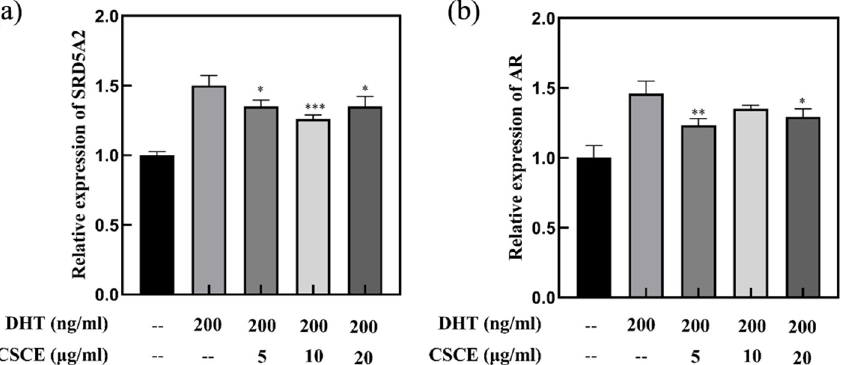
Figure 5. Effects of CSCE on the expressions of SRD5A2 ( a ) and AR ( b ) in DPCs. (Compared with DHT model group, * p < 0.05, ** p < 0.01, *** p < 0.001).